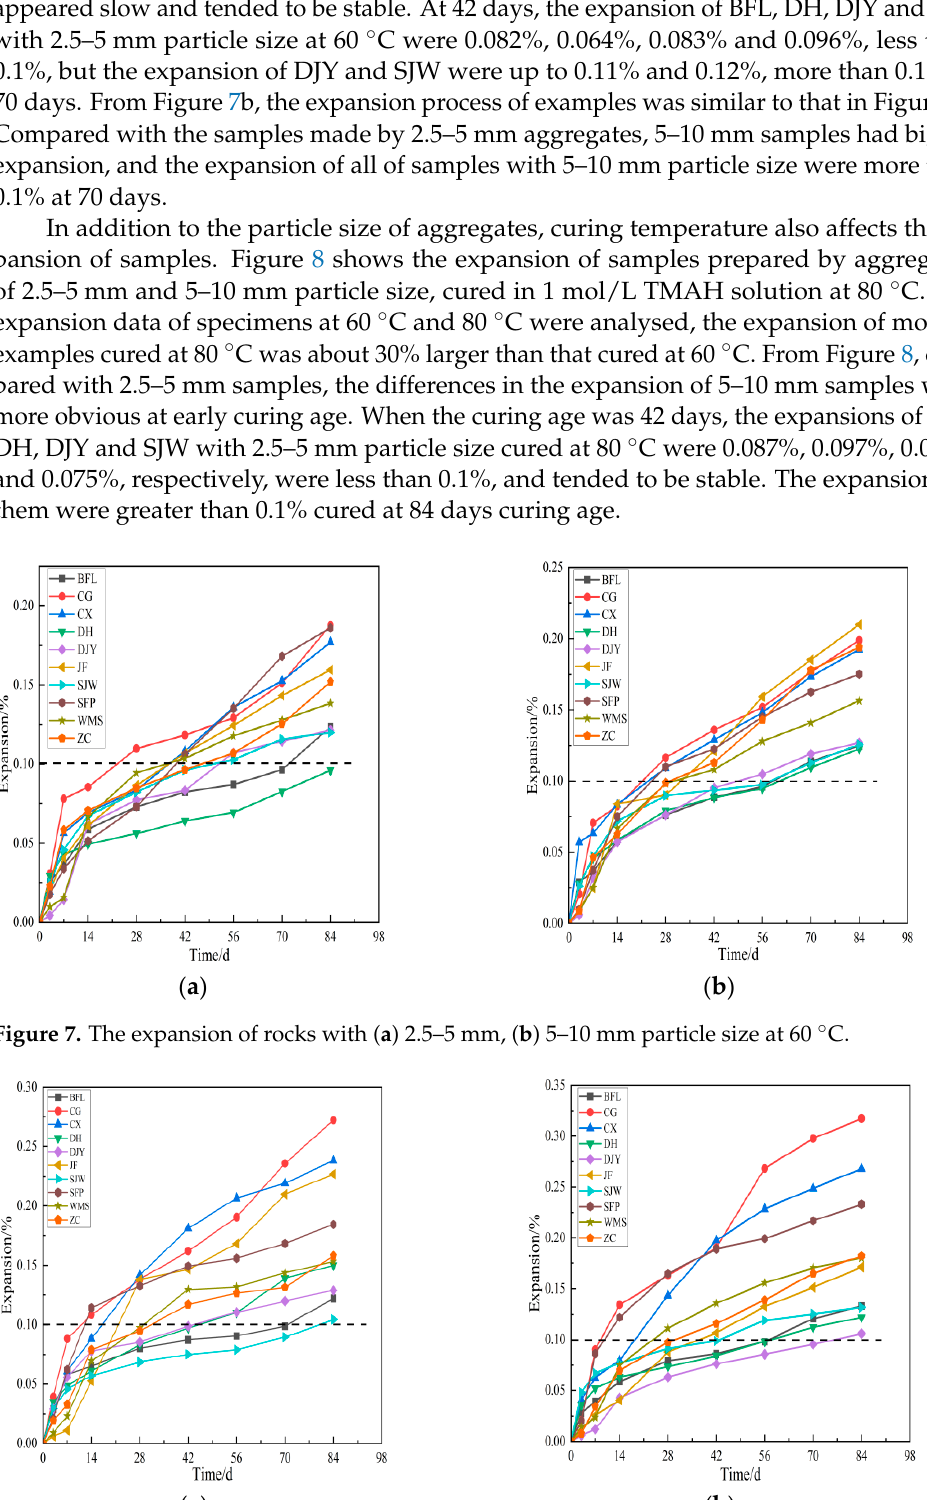
Figure 8. The expansion of rocks with ( a ) 2.5–5 mm, ( b ) 5–10 mm particle size at 80 °C. According to the ASTM C1105 standards, the BFL, DH, DJY and SJW aggregates had no ACR activity. From Figure 8b, the expansion of BFL, DH, DJY and SJW with 5–10 mm particle size cured at 80°C were 0.098%, 0.098%, 0.086% and 0.12% at 56 days, and their expansion were all less than 0.1% at 42 days. The expansion of samples prepared by all aggregates with ACR activity were more than 0.1% at 42 days. It can be seen from Figures 7 and 8, when the curing temperature and particle size increased, the expansion of sam- ples became larger. The difference of expansion between aggregates with and without ACR activity increases with the increase of temperature and particle size. Therefore, the conclusion can be drawn: the expansion of the specimen is greater than 0.1% at 42 days in 1 mol/L TMAH solution under curing condition of 80 °C, which can be used as a reference criterion to determine the alkali-carbonate reaction activity.